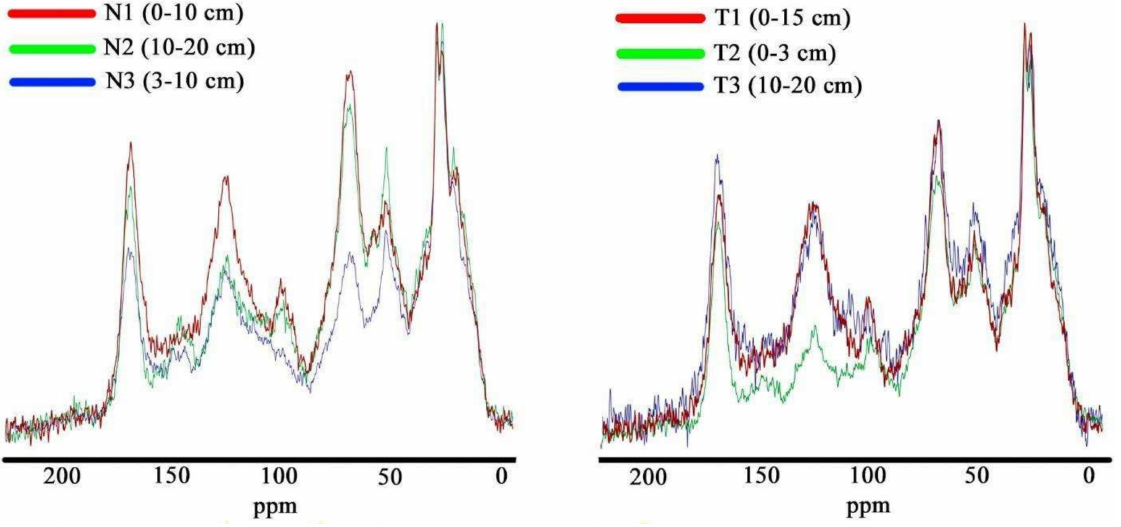
Figure 4. The 13 C NMR spectra of studied